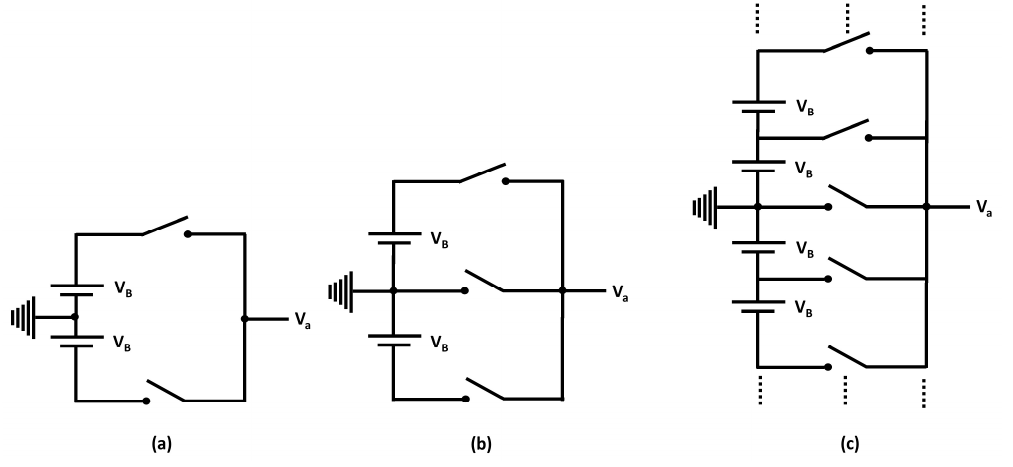
Figure 30. One leg of ( a ) 2-level, ( b ) 3-level and ( c ) n -levels inverter [37].